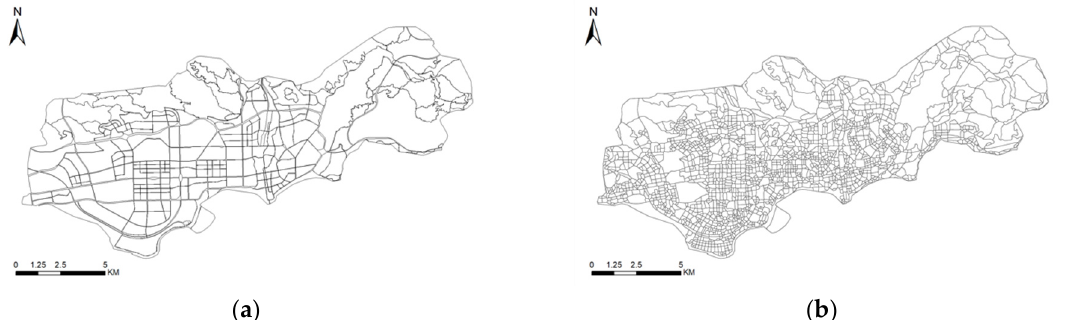
Figure 5. Evaluation parcel under two segmentation methods. ( a ) the scaling form under the head/tail breaks method. ( b ) the minimum evaluation parcel presented with the traditional “thinning expansion” segmentation method.